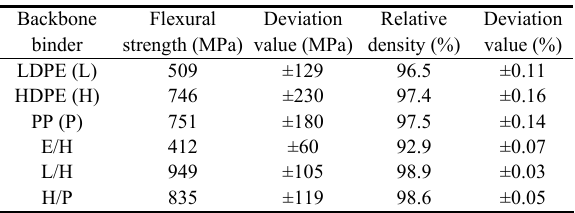
Table 2 Mechanical properties and relative density of the samples sintered from the feedstocks with various thermal polymers